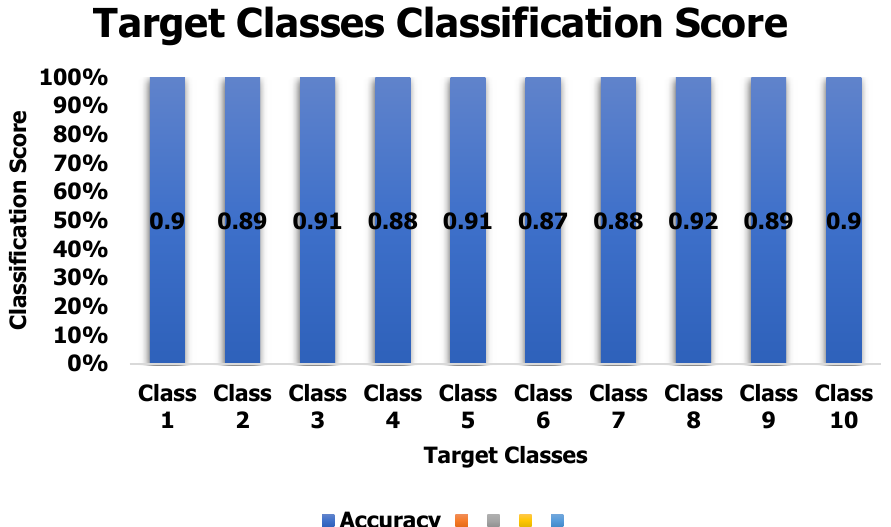
Figure 5. Classification score for the individual target classes.